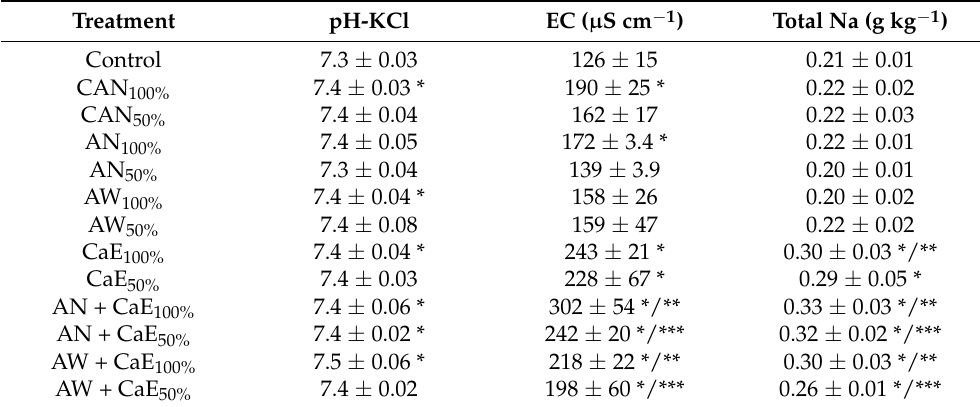
Table 8. Mean ± standard deviation of pH-KCl, electrical conductivity (EC), and total Na content in soil samples on a dry matter basis after lettuce harvest (n =